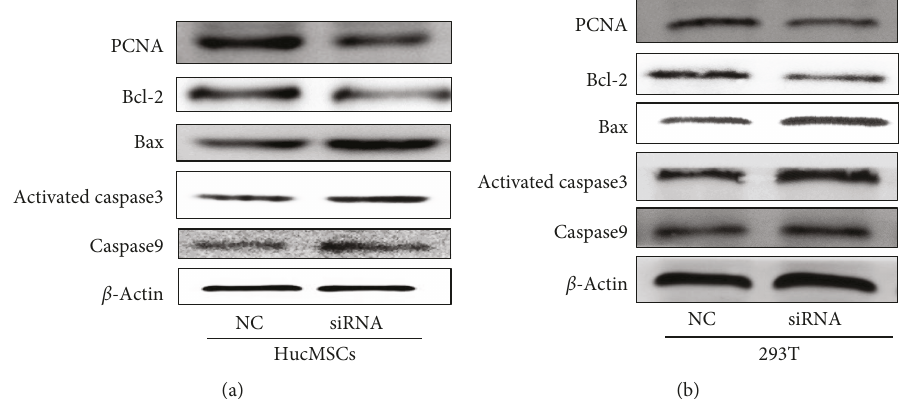
Figure 4: The expression changes of proliferative and apoptotic-related proteins. (a) Western blot for PCNA, Bcl-2, Bax, activated-caspase 3, and caspase 9 expression in hucMSCs after transfection with siRNA or control. (b) Western blot for PCNA, Bcl-2, Bax, activated-caspase 3, and caspase 9 expression in 293 T after transfection with siRNA or